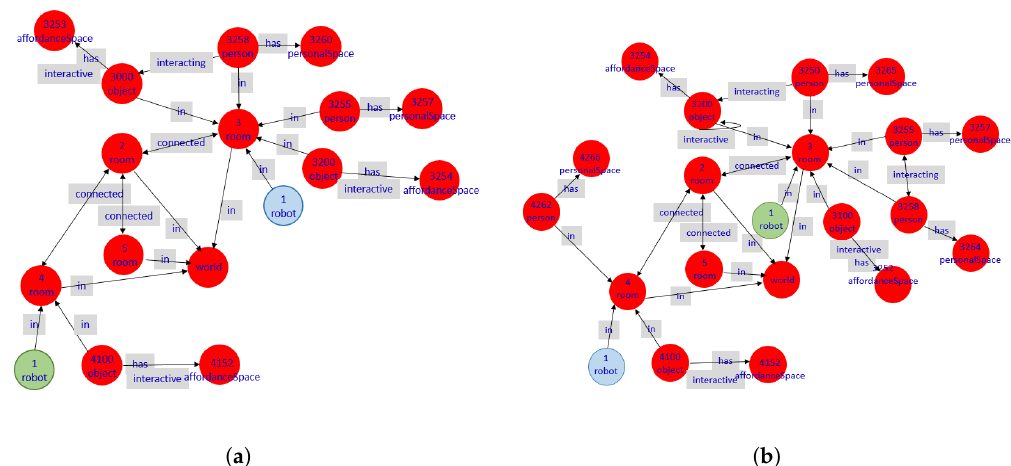
Figure 13. ( a,b ) Graph representation of the digital twin model C corresponding to the physical world W for the two use cases, respectively. The green node labeled as ’robot’ is the SAR location at the beginning of each test. This node, like the SAR in W , moves through the graph. The blue node is the SAR location at the ending of each